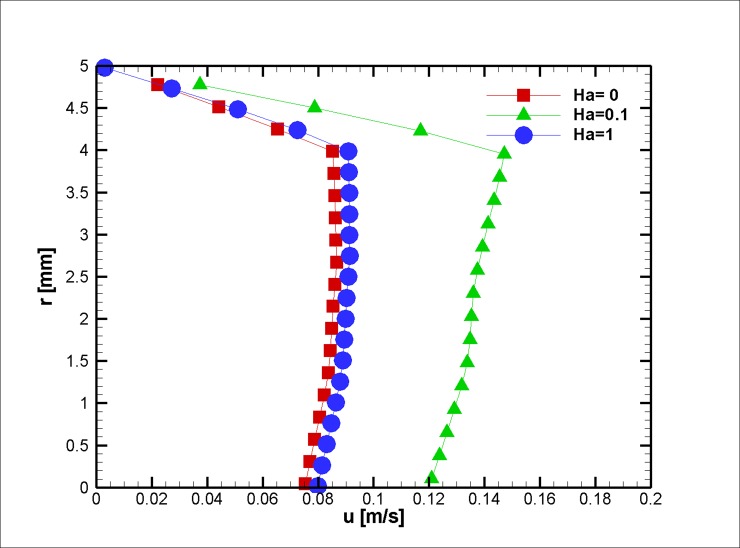
Velocity in axial direction distribution for three different Ha Number at z = 2 cm at t = 0.75 s, Lvessel = 7 cm, Rvessel = 1 cm and fifty percent stenosis.